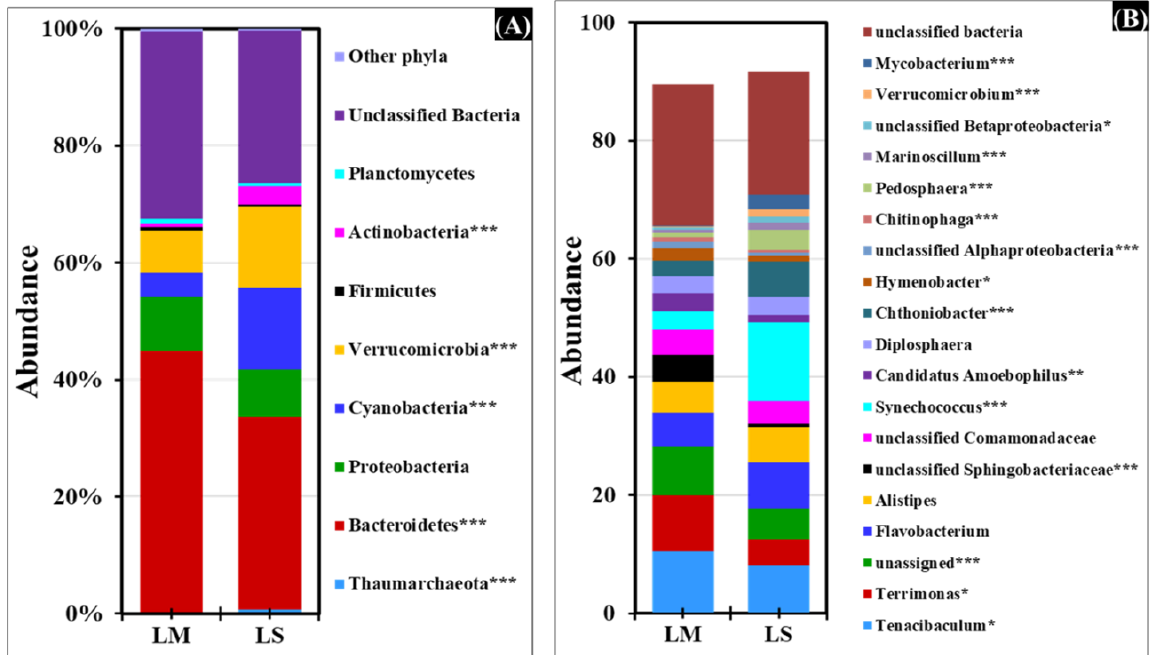
Figure 5. Stacked bar chart representing the relative abundance of different ( A ) phyla and ( B ) gen- era/families across Lakes Michigan and Superior. The top 20 taxa, by abundance, are shown for clarity. Significant differences among the lakes were computed using Mann–Whitney U test. * p < 0.05, ** p < 0.001, and *** p <0.0001. The significantly different phyla/genera/families among the lakes are shown in the figure description.